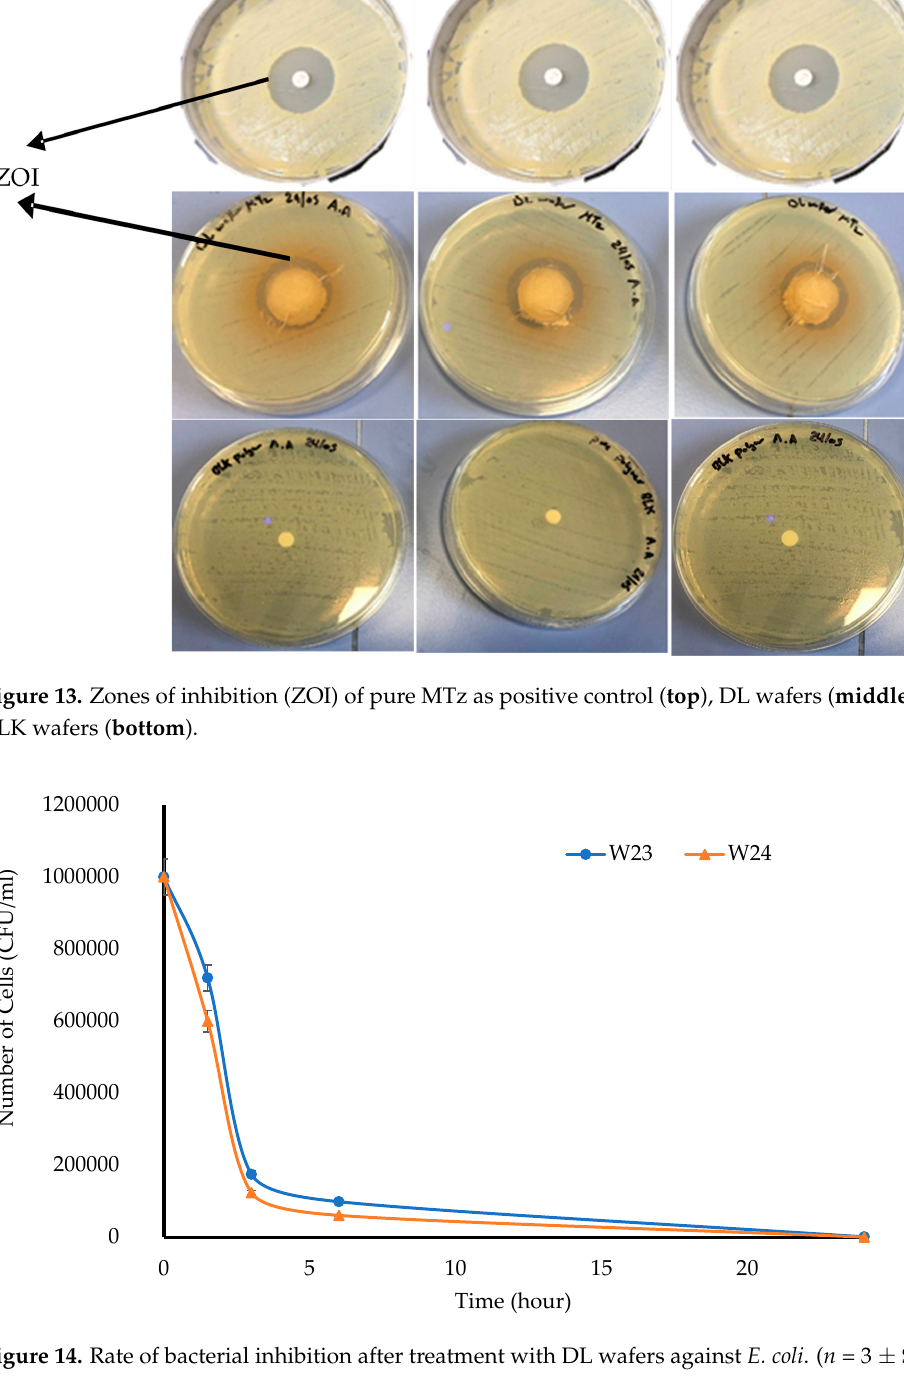
Figure 14. Rate of bacterial inhibition after treatment with DL wafers against E. coli . ( n = 3 ±